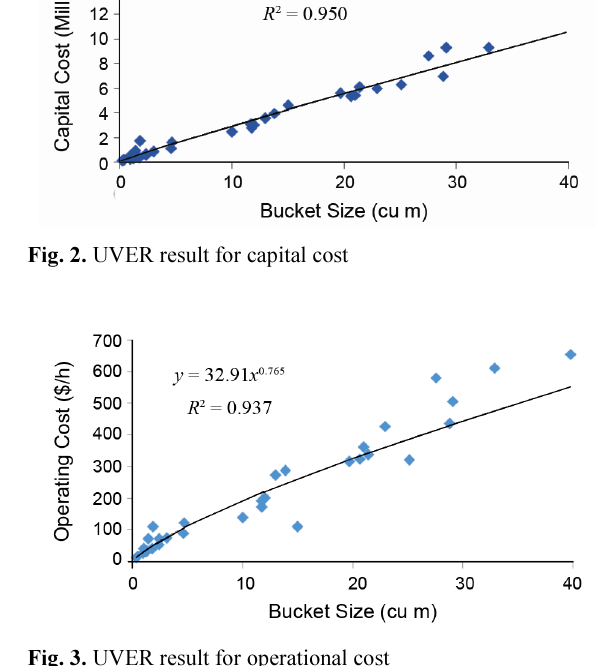
Fig. 3. UVER result for operational cost